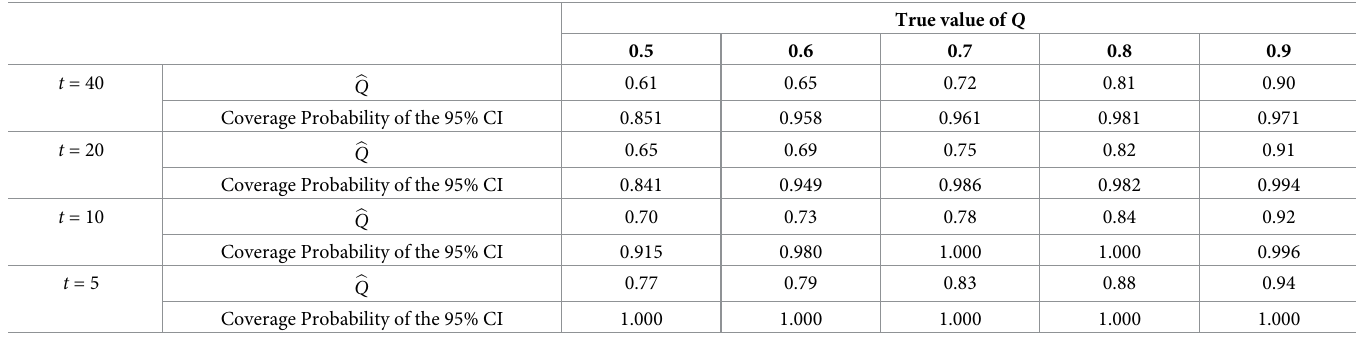
= 0.8, a = i 7 ρ i 7